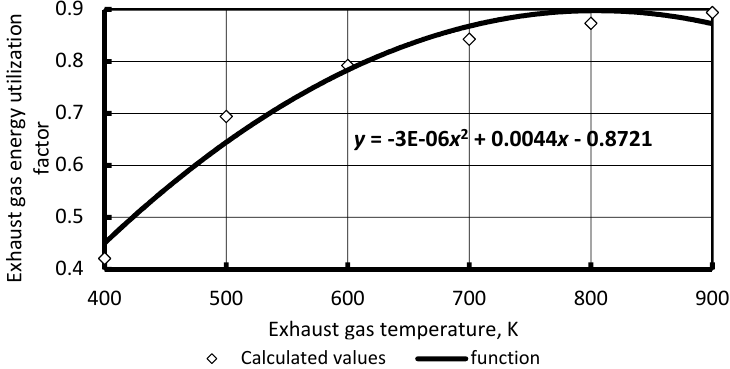
Figure 16. Exhaust gas energy utilization factor. Source: developed by authors.